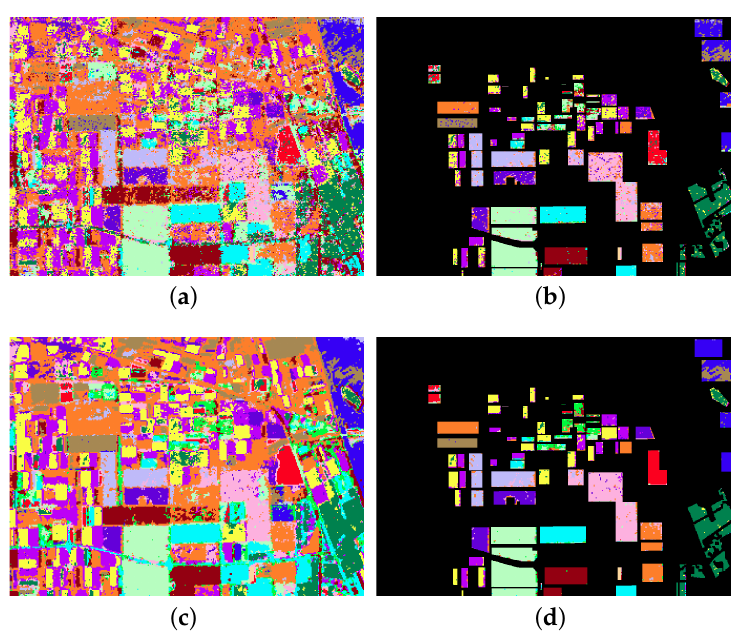
Figure 12. The visual classification results by CNN and QCNN on Flevoland data set. ( a ) The classification result obtained by CNN. ( b ) The result map ( a ) overlaid with the ground truth map. ( c ) The classification result obtained by QCNN. ( d ) The result map ( c ) overlaid with the ground truth map.